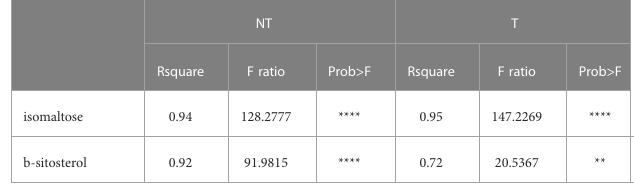
TABLE 4 Correlation between morphological traits (root and epicotyl lengths) and metabolites ’ content for non-treatment (NT) and treatment (T) conditions in durum